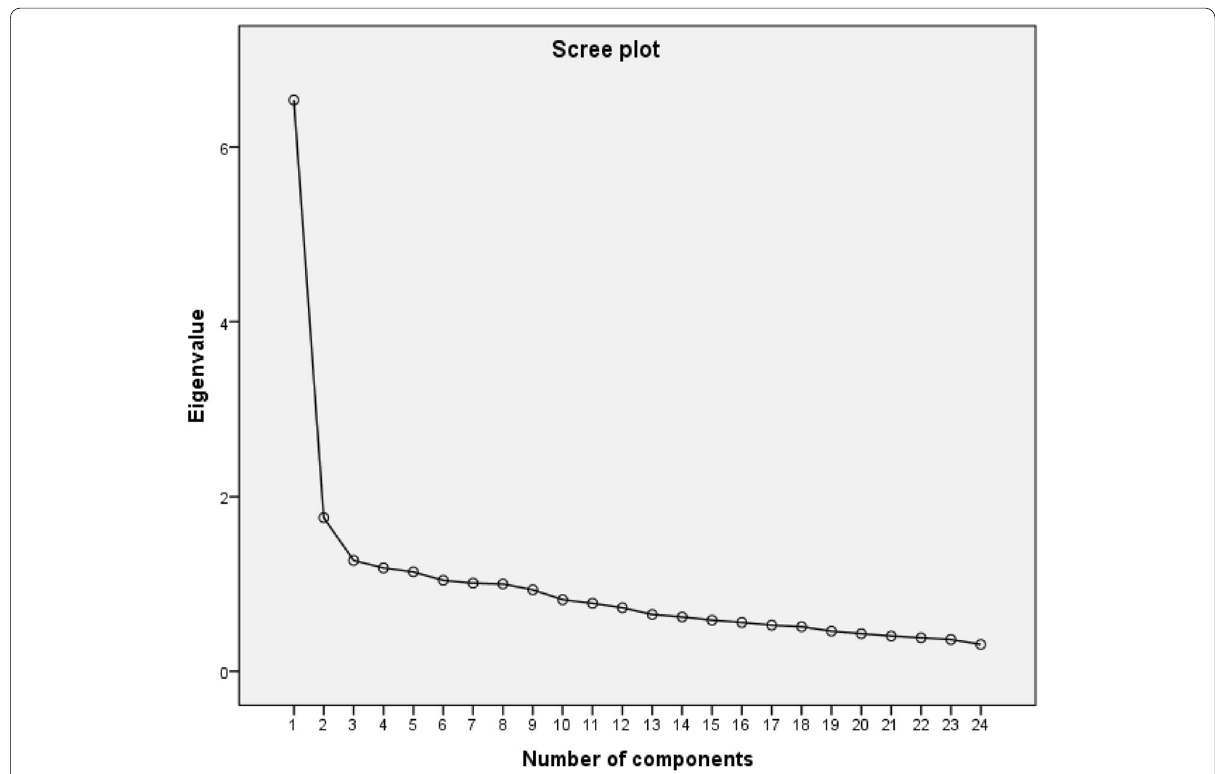
Fig. 1 Scree plot test for number of factors of the EEAPREJ